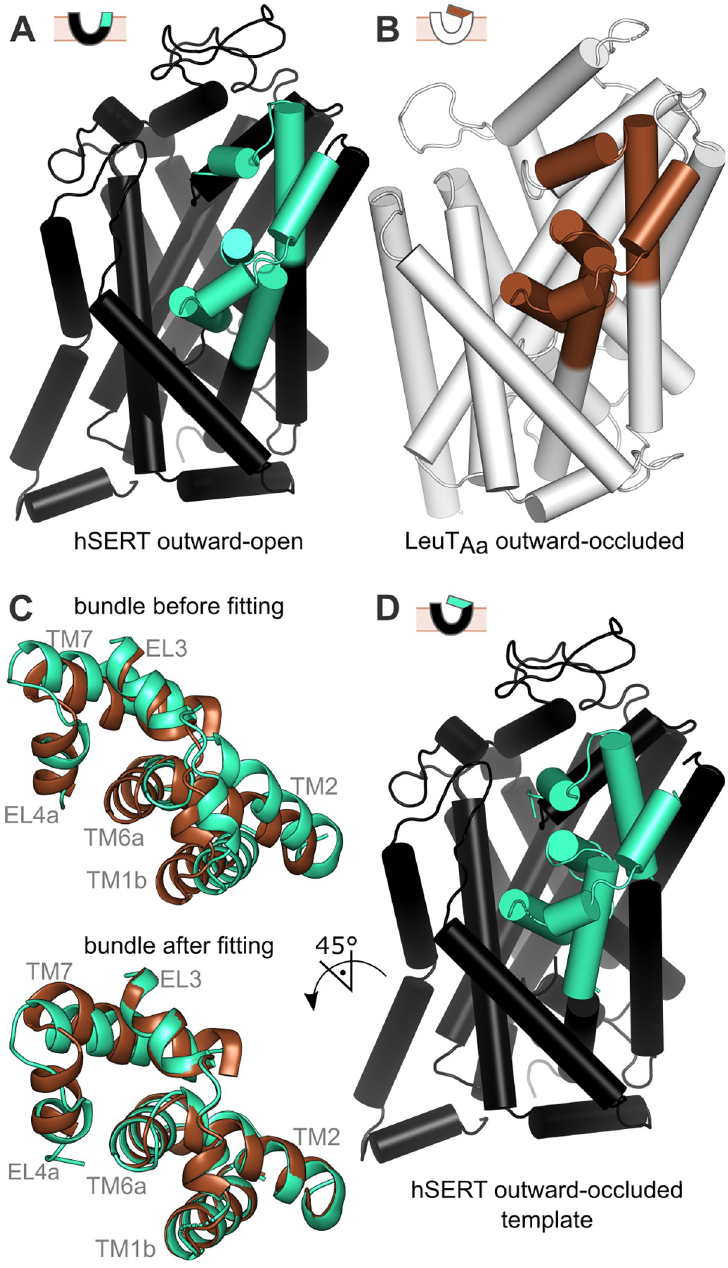
Fig 3. Model-building process. (A, B) The two template structures used were outward-open hSERT (A, PDB ID: 5I71) and outward-occluded LeuT Aa (B, PDB ID: 3F48). The extracellular bundle components whose conformations define the occlusion of the extracellular pathway in NSS transporters are shown in green (hSERT) and brown (LeuT Aa ). C) To reposition the outward-open hSERT bundle segments according to their expected locations in the outward-occluded state, the former were individually superposed onto the corresponding elements of LeuT by structural alignment. D) The resultant modeling template consists of the unchanged segments (black) plus the now outward-occluded, repositioned bundle segments (cyan), both originate from hSERT